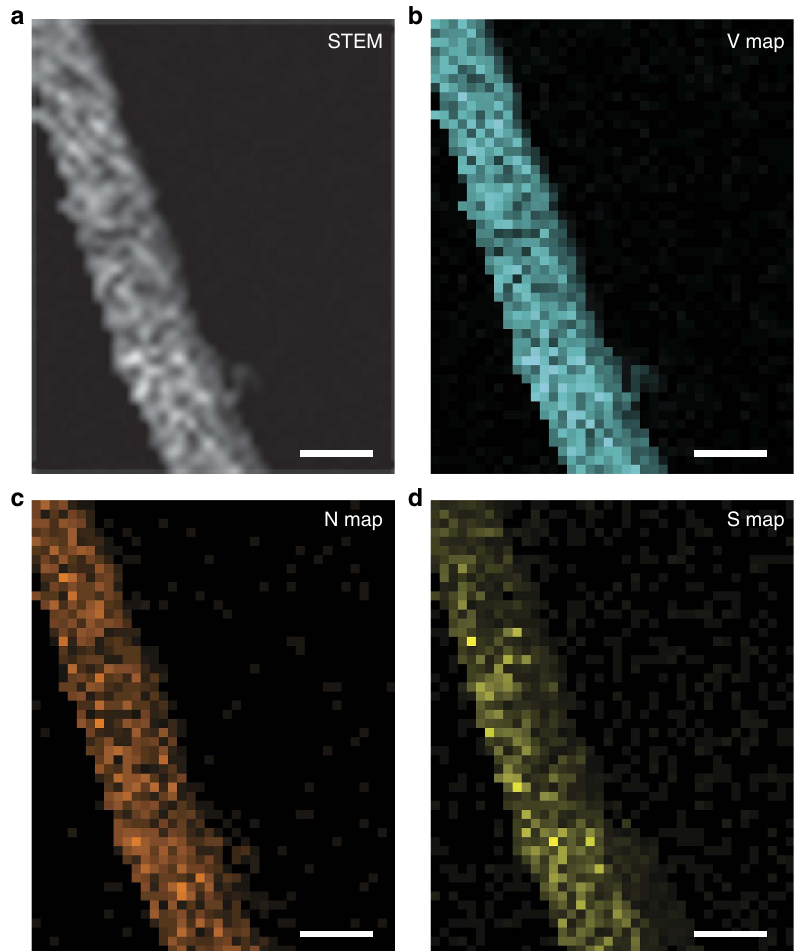
Figure 6 | Sulfur distribution in the VN nanoribbons after cycling. ( a ) STEM image of a VN nanoribbon after cycling with the corresponding elemental maps of ( b ) vanadium, ( c ) nitrogen and ( d ) sulfur. Scale bars,